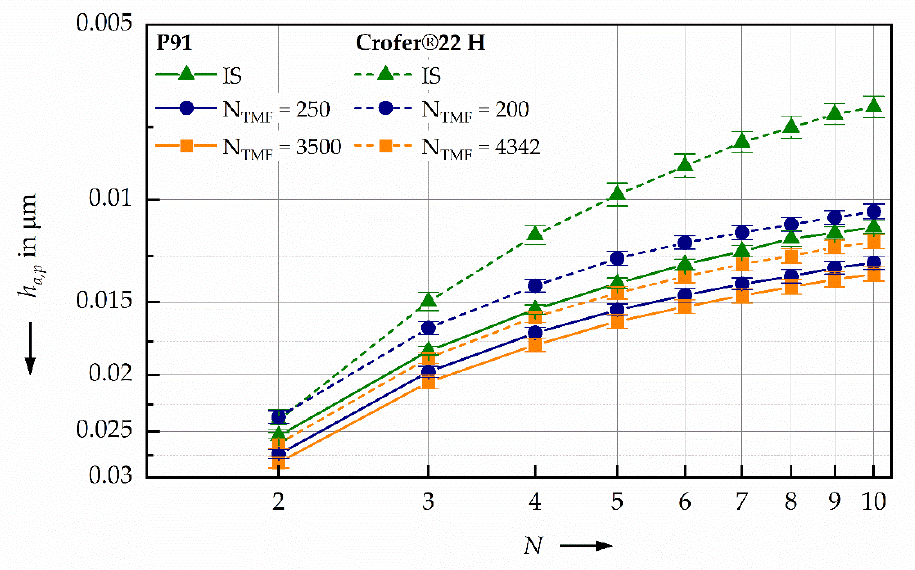
Figure 6. Comparison of the h a,p -N curves of specimens made of P91, as well as Crofer ® 22 H and loaded for a different number of TMF-cycles N TMF .